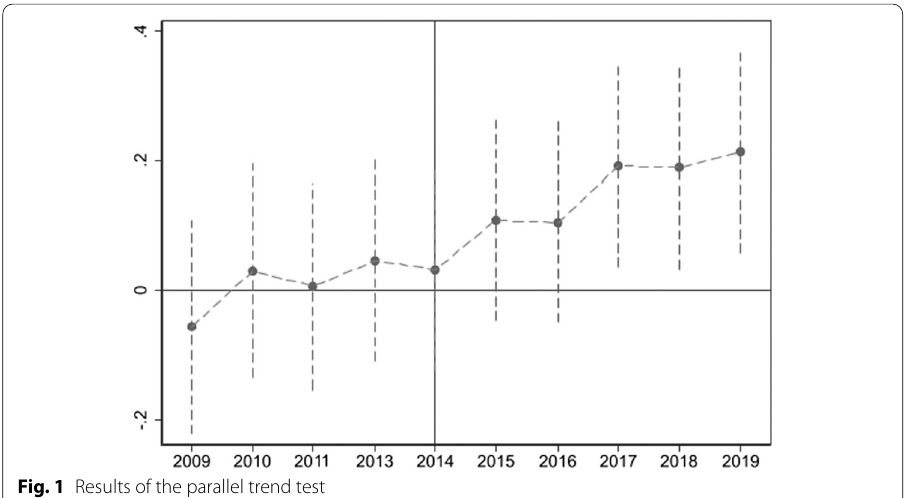
Fig. 1 Results of the parallel trend